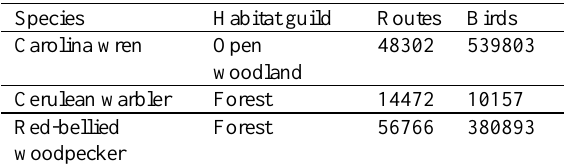
Table 1. Statistics of bird observations during 1967-2014. Habitat guilds were classified according to the rules of habitat type classifications proposed by the Cornell Lab of Ornithology.